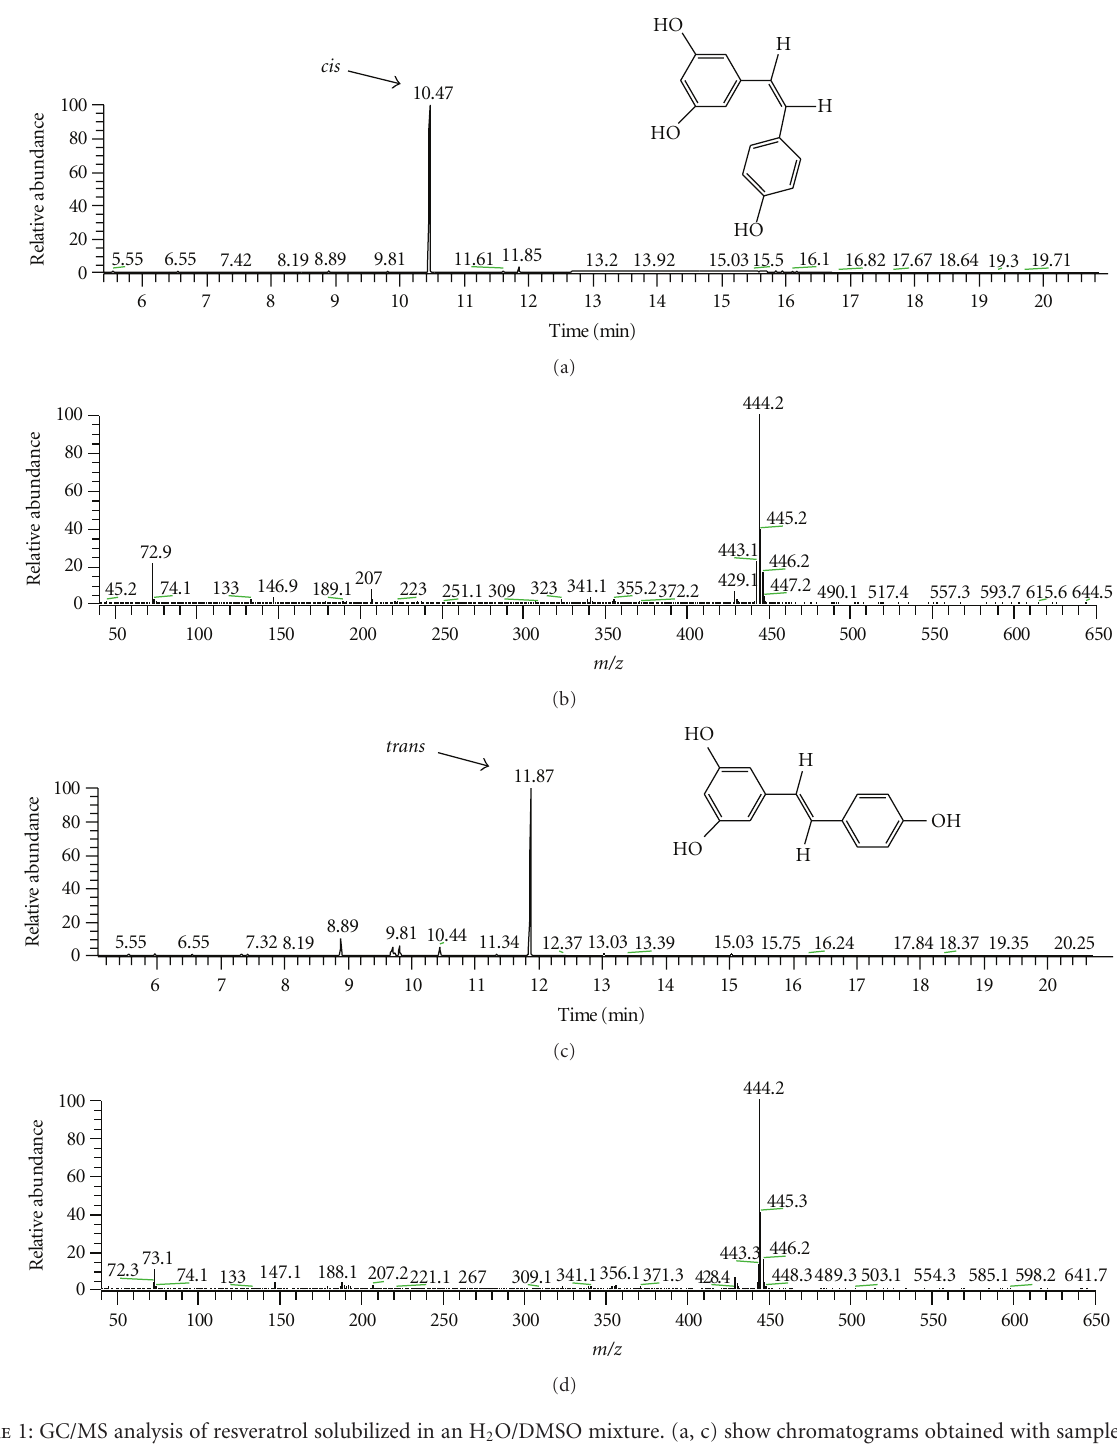
Figure 1: GC/MS analysis of resveratrol solubilized in an H 2 O/DMSO mixture. (a, c) show chromatograms obtained with samples placed either in light (a) or in darkness (c). (b, d) represent mass spectrum of cis- and trans -resveratrol, respectively. The analysis conditions are detailed in Section